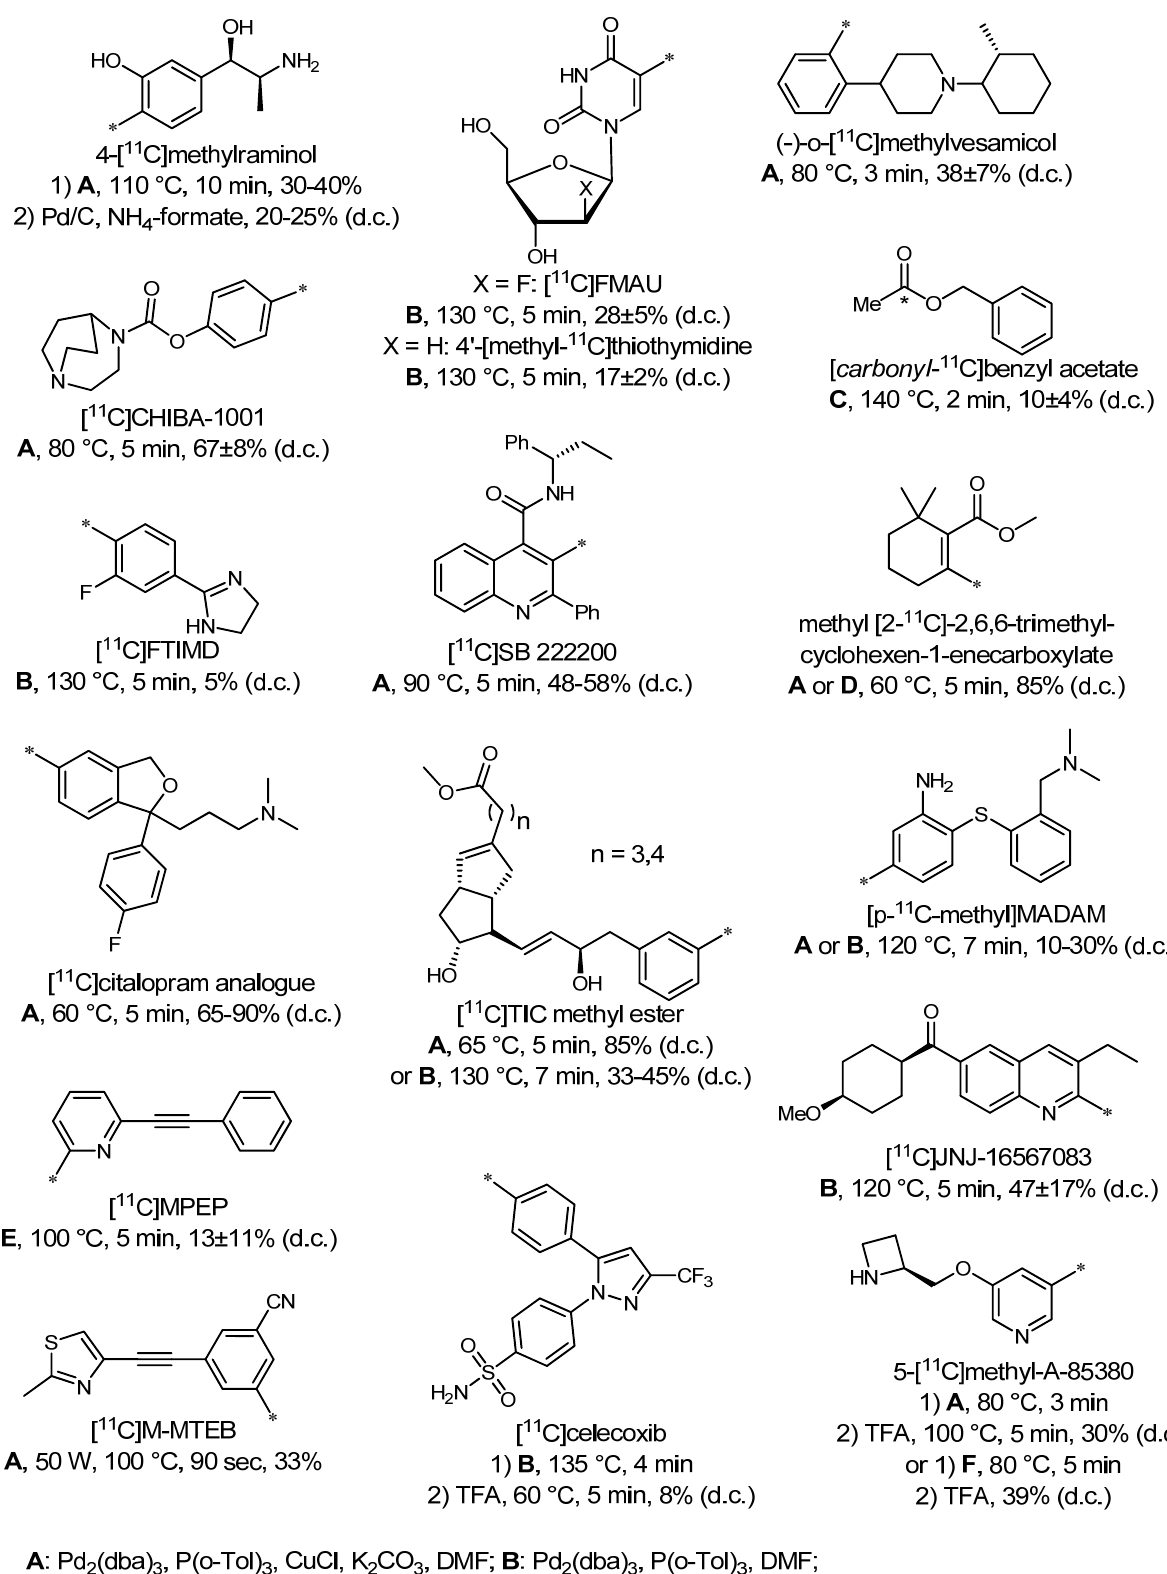
Figure 1. Overview of [ 11 C]radiotracers prepared by Stille